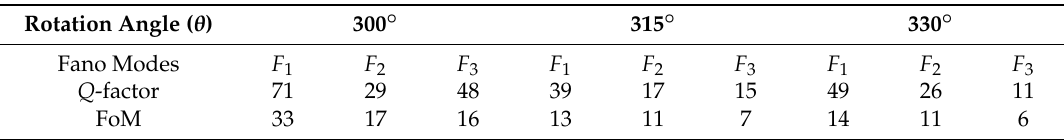
Table 1. Q -factor and FoM values around Fano